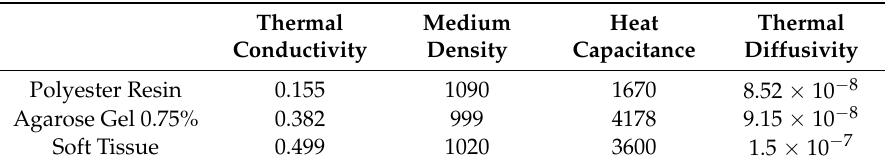
Table 1. Thermal properties of different